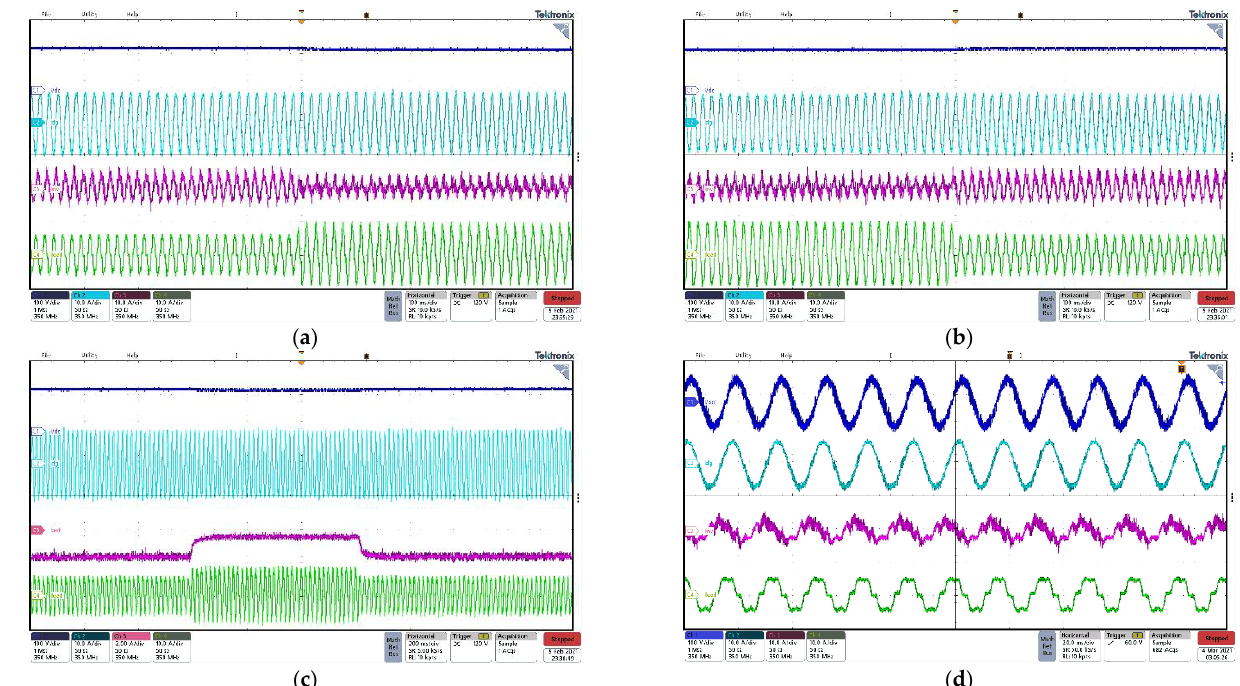
Figure 12. Experimental behavior of the system under varying load ( a ), ( b ), and ( c ) and non-linear load ( d ).